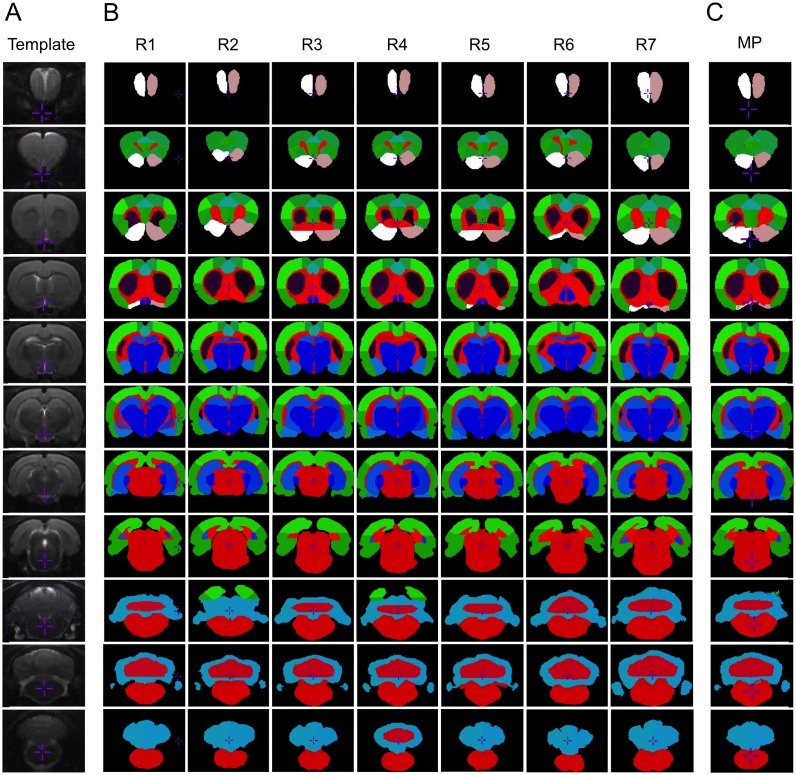
Multi-atlas dataset and maximum probability atlas.Rat MRI template (A) composed from 7 individuals. Dataset of 7 individual atlases (B). Maximum probability atlas (C), combination of the 7 individual atlases. Coronal slices, 2 mm apart (one slice out of five are shown).